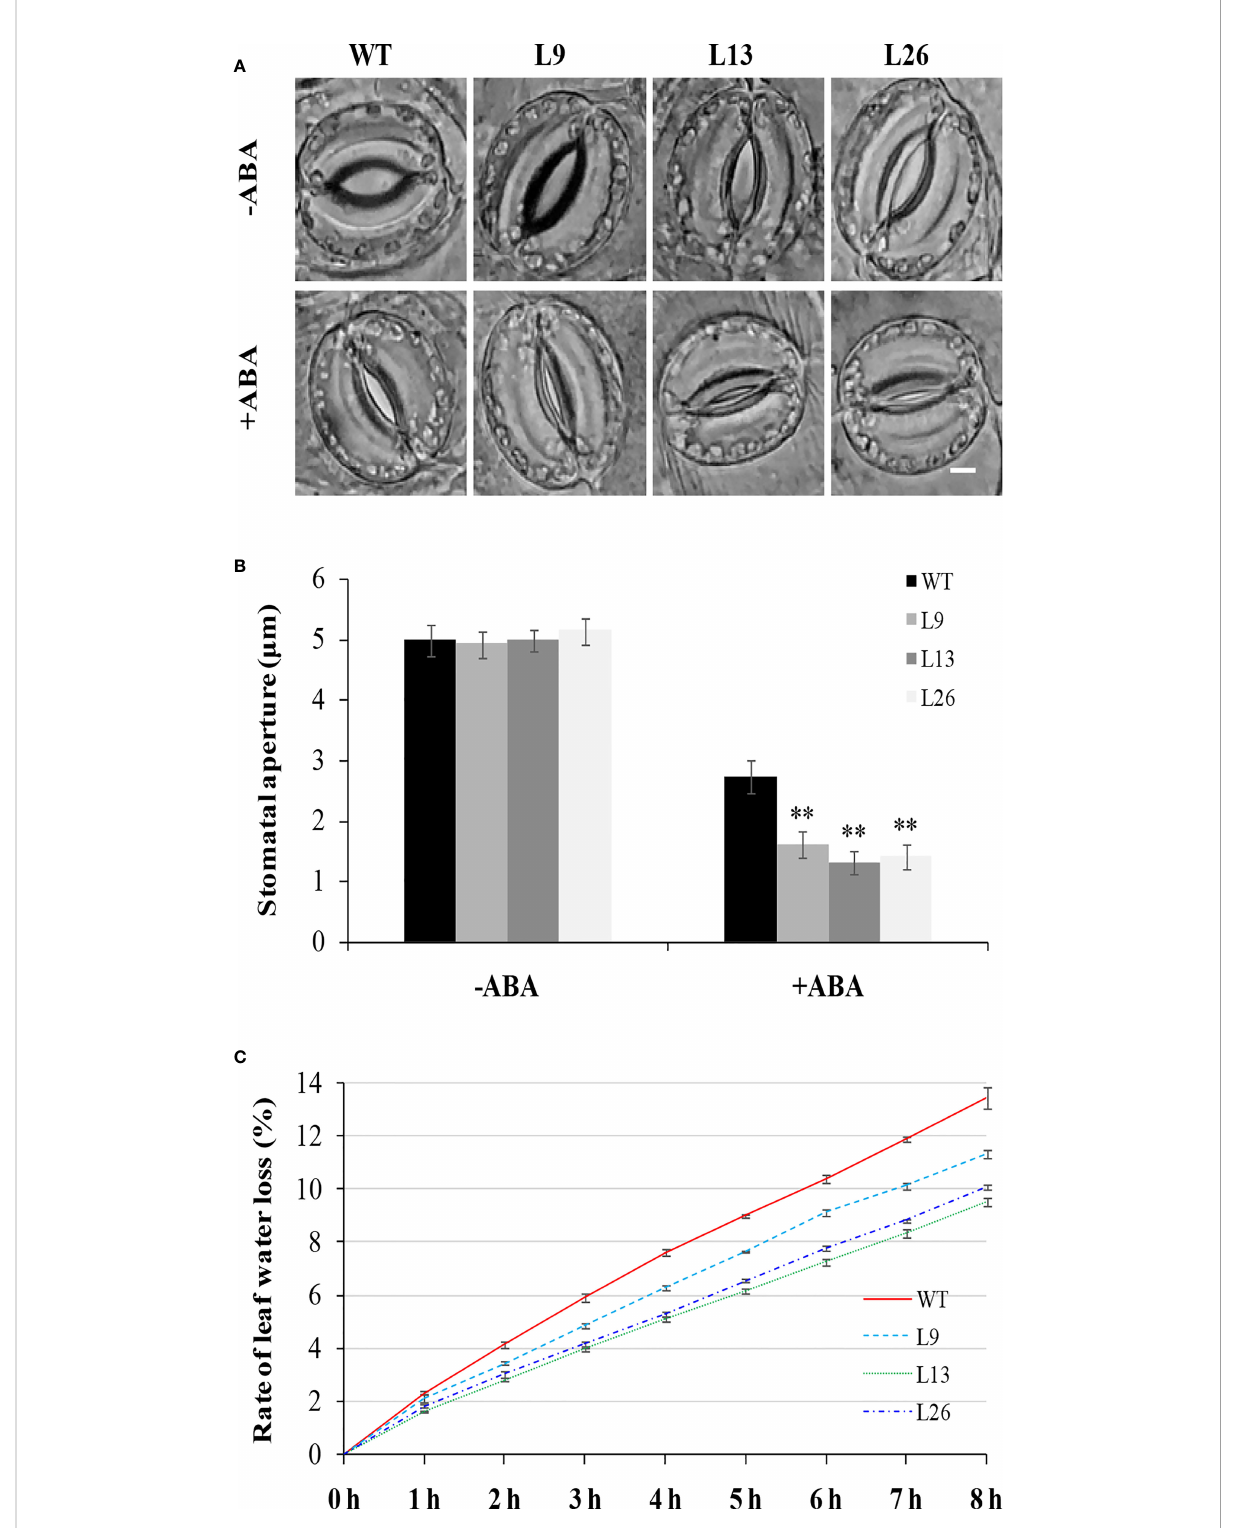
FIGURE 6 Stomatal aperture and leaf water loss rate of transgenic sweet potato plants and WT. (A, B) Stomatal aperture of greenhouse-grown plants under normal condition (-ABA) and treated with 20 m M ABA for 2 h. Bar = 5 m m. Data are presented as the means ± SD (n = 80). ** indicates signi fi cant difference from that of WT at P <0.01, according to Student ’ s t -test. (C) Leaf water loss rate of greenhouse-grown